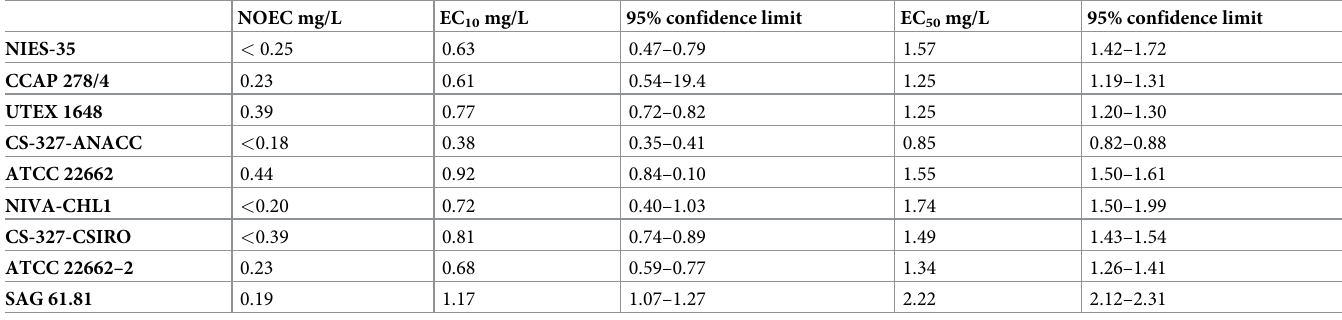
Table 4. Sensitivity to